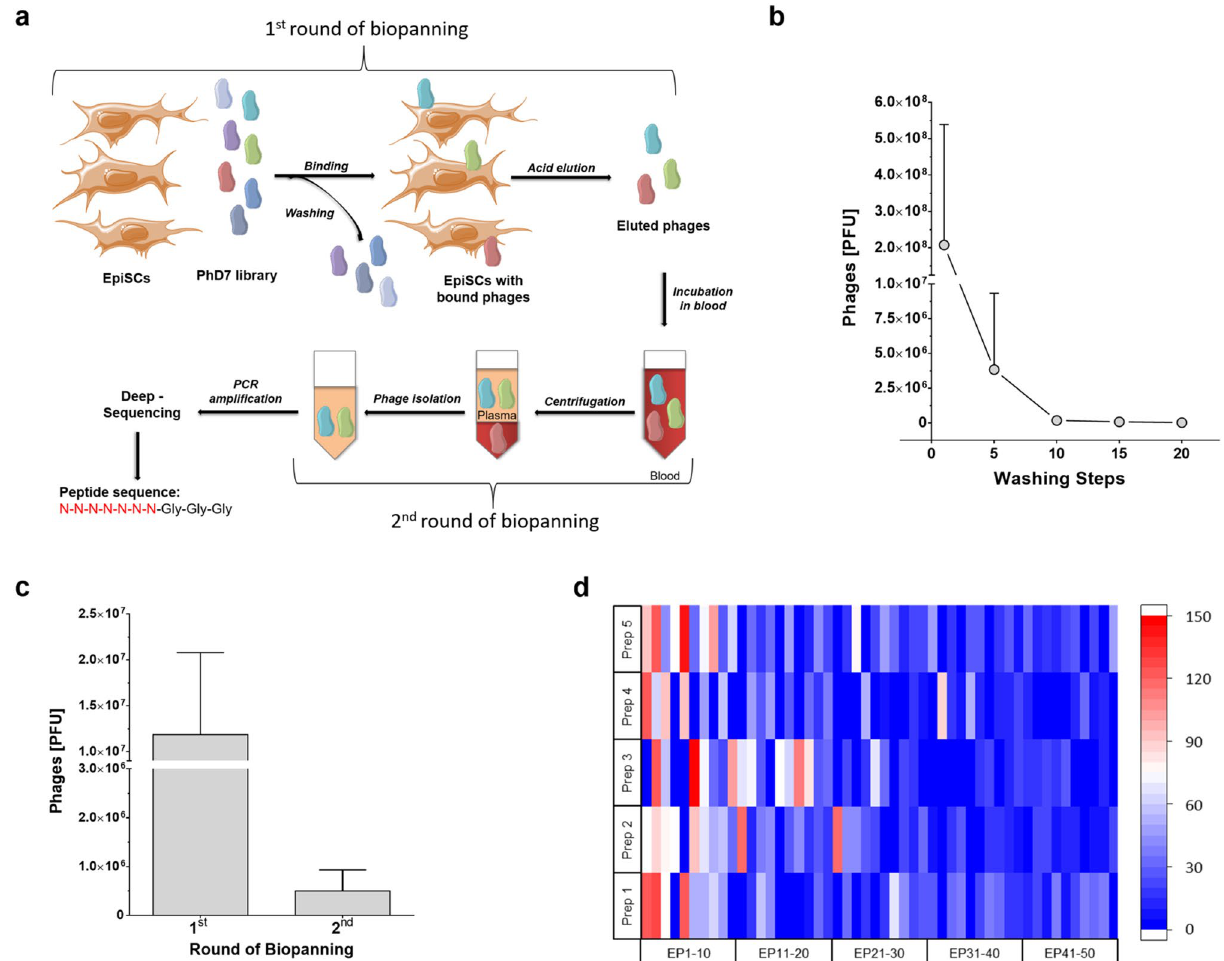
Figure 1. ( a ) Schematic overview of the phage-display screening approach: phage from the PhD7 library were incubated with cultured EpiSCs, intensively washed and eluted at low pH (1st round of biopanning). Subsequently, isolated phage were incubated with blood to remove phage clones that bound to cellular components of blood (2nd round of biopanning). Phage isolated from the blood plasma were subjected to deep sequencing and bioinformatics analysis. ( b ) After incubation with the PhD7 phage library, EpiSCs were intensively washed and the amount of released phage per washing step was determined by qPCR (Mean ± SD; n = 5). ( c ) Total number of phage (± SD of n = 5) which were obtained after the first and second round of the biopanning procedure. ( d ) Enrichment of EpiSC specific peptides sequences (EP): the relative increase of the 50 most abundant peptide sequences in the five separate phage isolations from the 2nd round of the biopanning procedure. Enrichment was calculated in relation to the parent PhD7 phage library and is displayed as color- coded heat map. EPs (EP1-EP50) were arranged according to their mean relative enrichment. Prep = individual preparation number of EpiSCs. Parts of the figure were drawn by using pictures from Servier Medical Art (http://smart .servi er.com/).